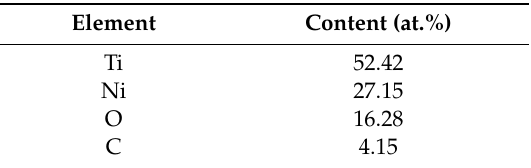
Table 3. Energy-dispersive X-ray spectroscopy (EDS) analysis of nonmetallic inclusions at the crack origins in a fatigue fracture surface of C300O300 wire.